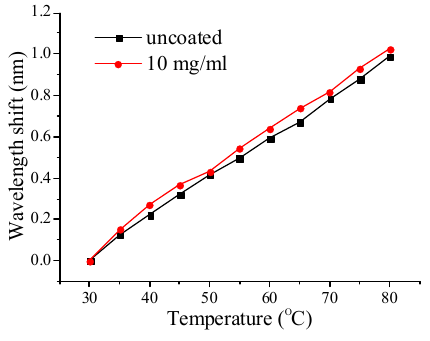
Figure 6. Wavelength shift vs. temperature for the SMF–HCF–SMF fiber structure with and without a coating of GO.